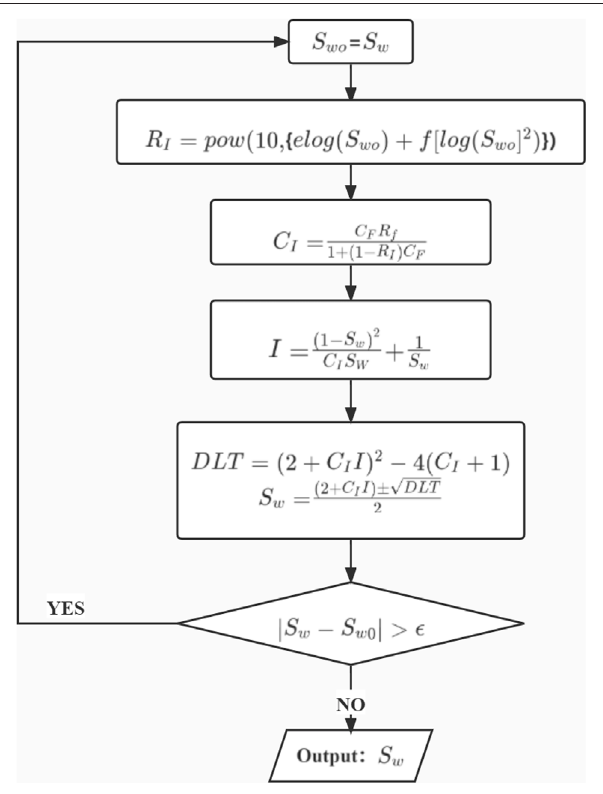
FIGURE 7 | Work fl ow of saturation estimation of iterative